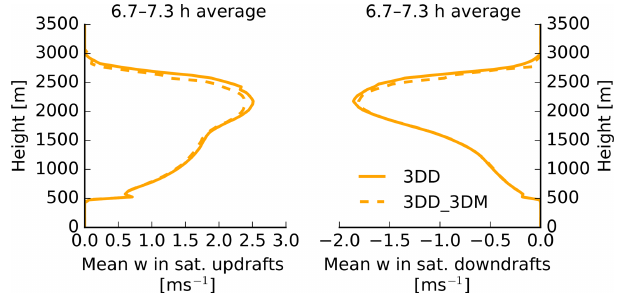
Figure 18. Time-averaged profiles of updraft and downdraft vertical velocity in saturated areas averaged from 6.7 to 7.3h.